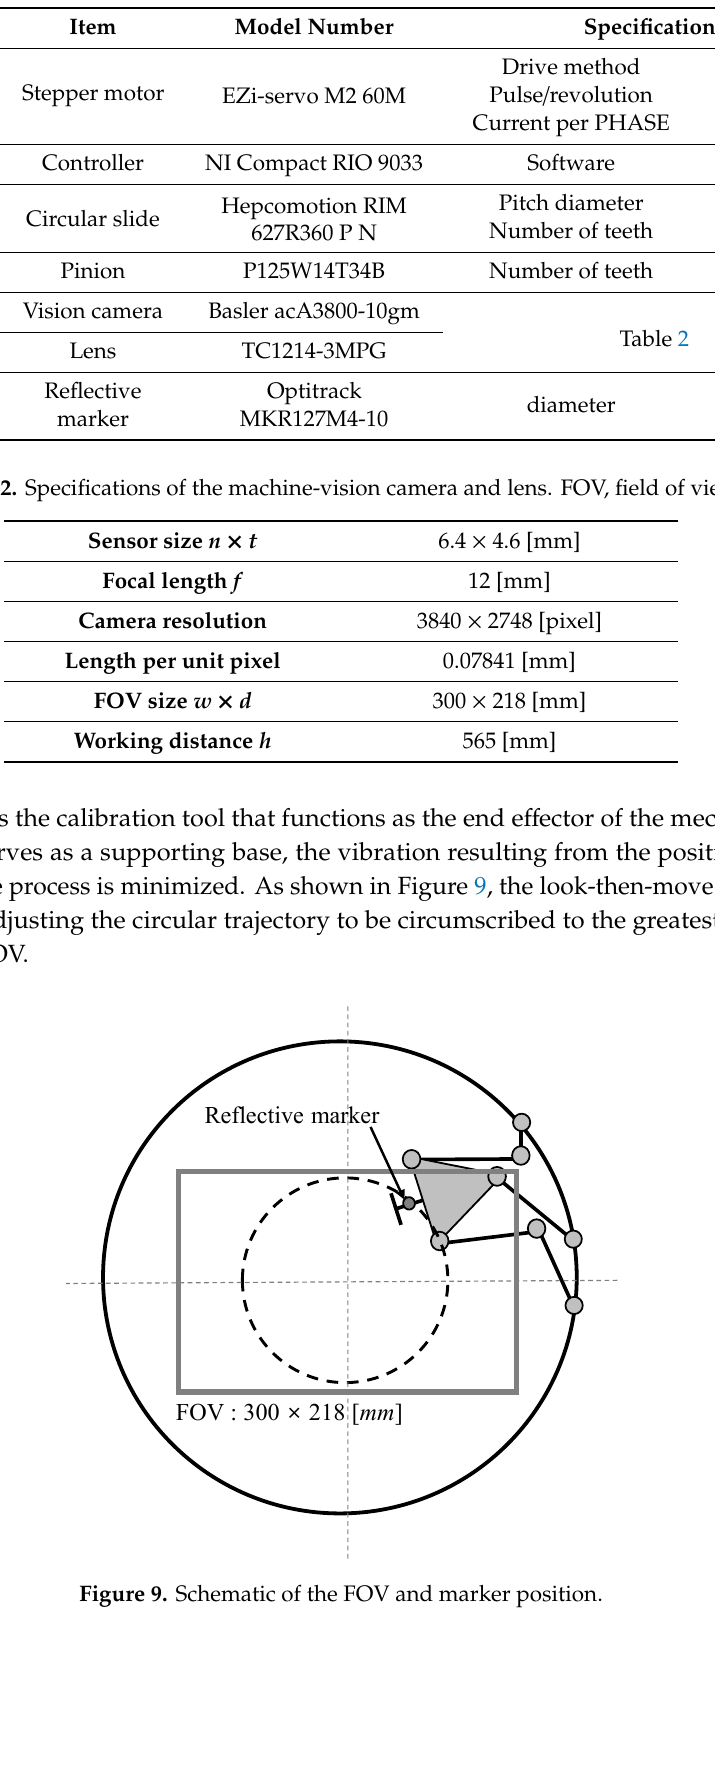
Table 1. Information about all the hardware and software used in this study.